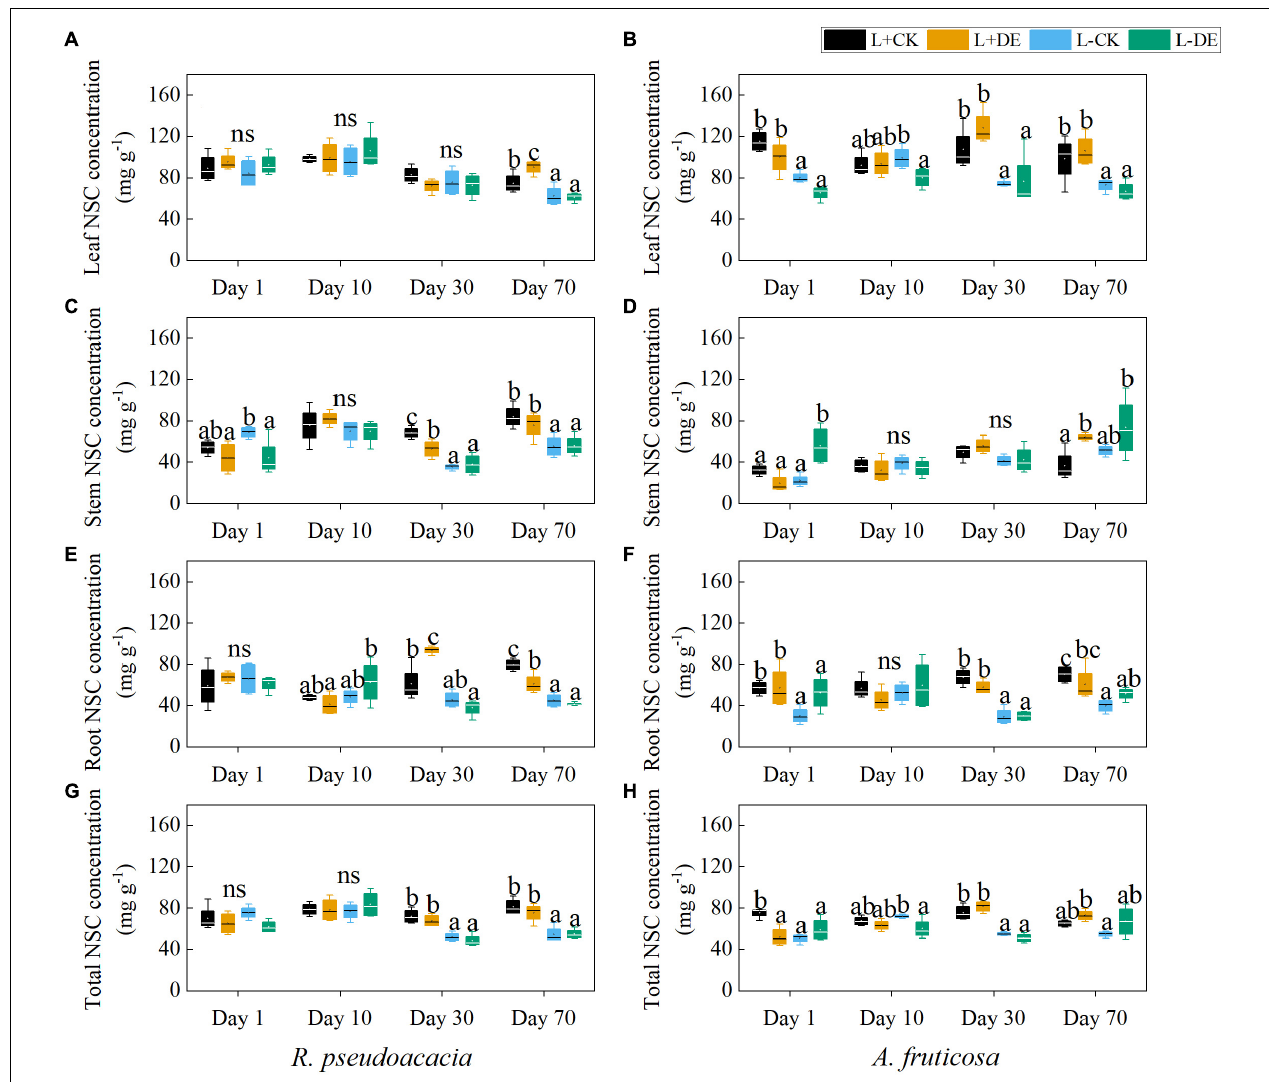
FIGURE 6 | Seedling organs and total non-structural carbohydrate (NSC) concentration of R. pseudoacacia (A,C,E,G) and A. fruticosa (B,D,F,H) under different light and defoliation treatments. The values are shown as mean ± SE ( n = 4). Different letters indicate significant differences among different treatments at each sampling according to Duncan’s test ( p < 0.05). L + CK, high light condition with no defoliation; L + DE, high light condition treatment with defoliation; L − CK, low light condition with no defoliation; L − DE, low light condition with